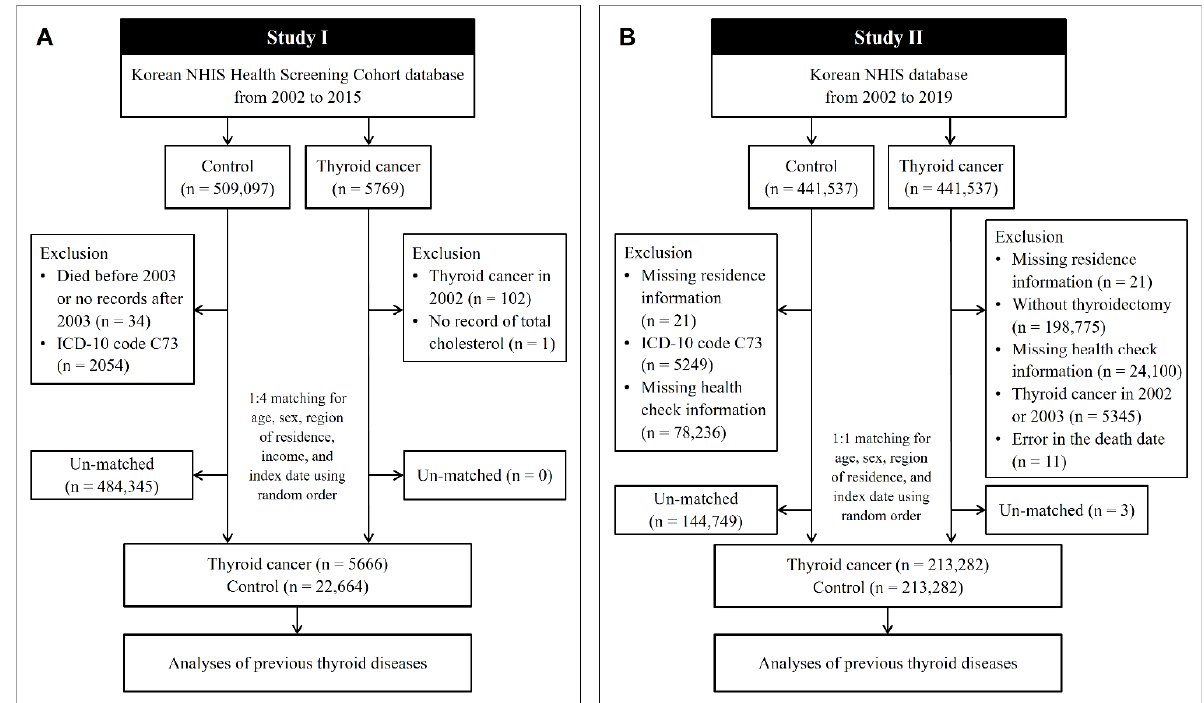
Figure 1. A schematic illustration of the participant selection process used in the present study. ( A ) In Study I, 5666 thyroid cancer patients were 1:4 matched with 22,664 control participants for age, sex, region of residence, and income. ( B ) In Study II, 213,282 thyroid cancer patients were 1:1 matched with 213,282 control participants for age, sex, and region of residence. NHIS, National Health Insurance Service; ICD, International Classification of